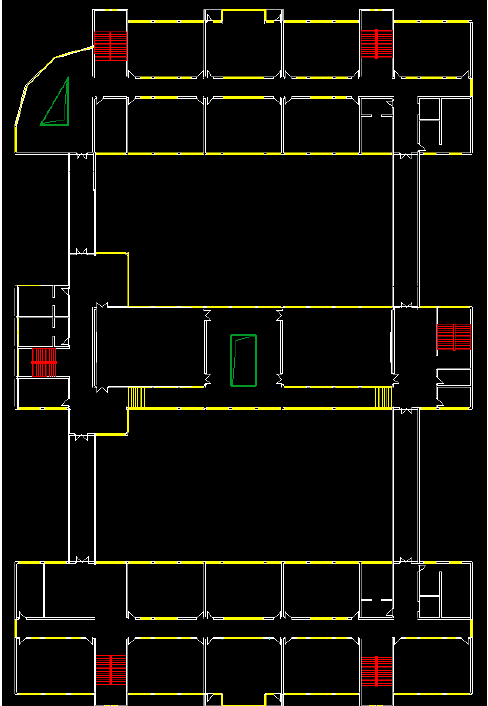
Figure 10. Demonstration of the comparing CAD blueprint